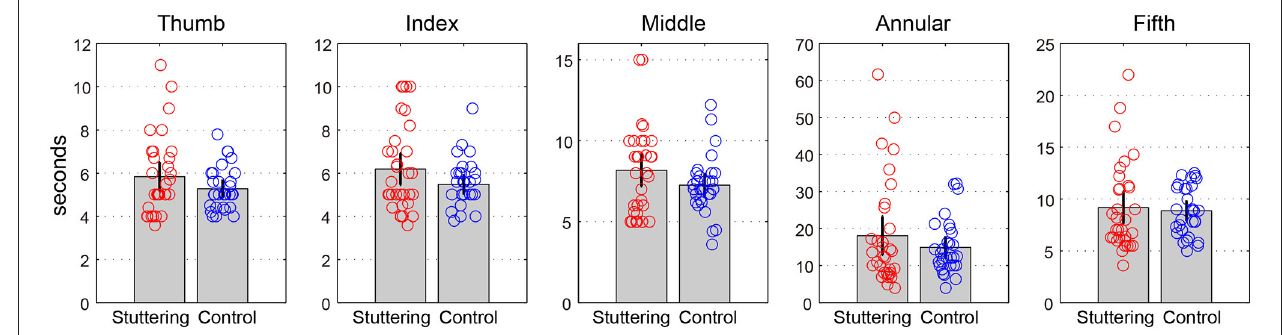
FIGURE 2 | Rotation task 1. The y-axis represents the amount of time (s) for the 10 rotations in each finger pair in s. Error bars represent 95% confidence intervals.